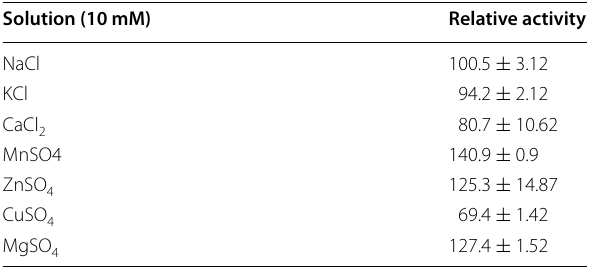
Table 1 Effects of metal ions on the activity of purified recombinant Bgl.bli1